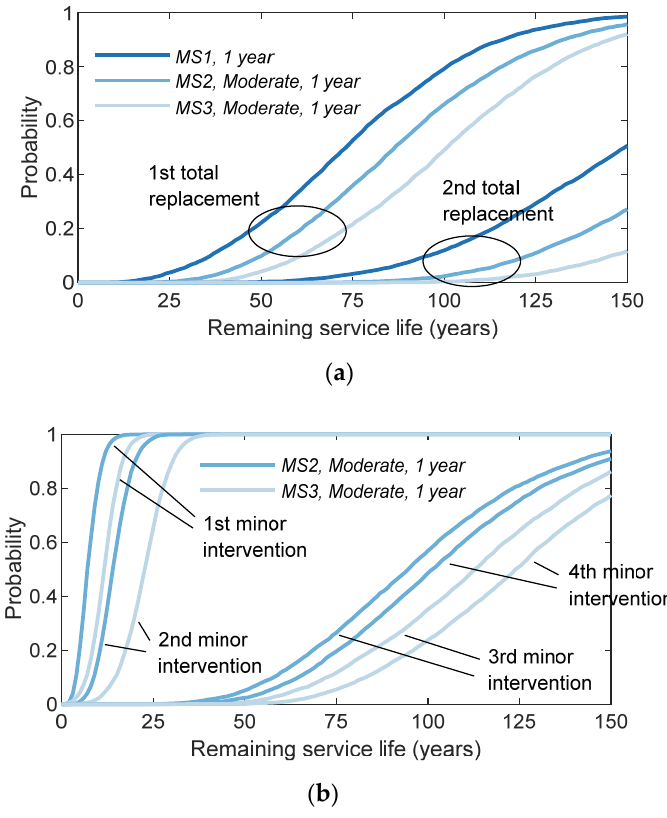
Figure 6. Cumulative distribution functions associated with the: ( a ) total replacement and ( b ) minor intervention.